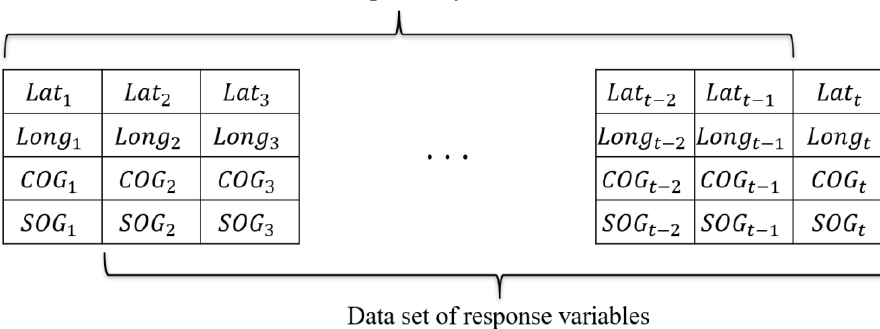
Figure 2. Structure of trajectory data for training of RNNs.